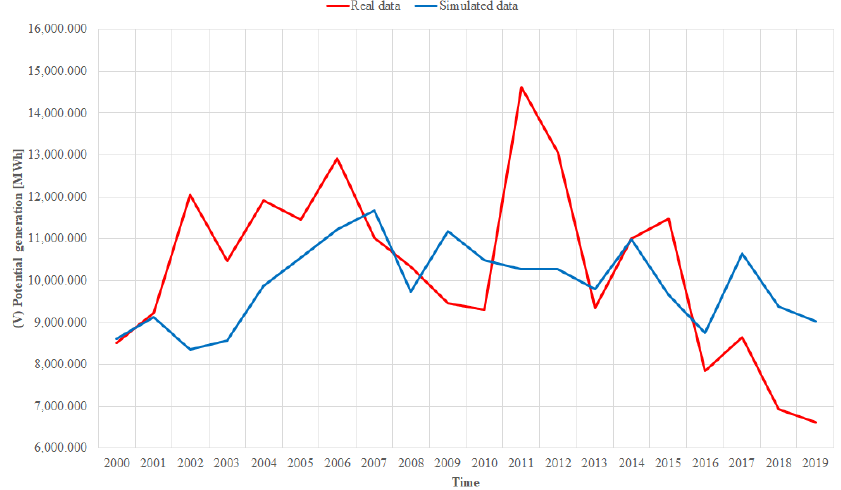
Figure 10. (V) Potential generation ( pg v ). The red signal represents the real behavior of the Colombian potential generation of the variable resources, obtained with data from [44]. The blue signal was computed with our SD/DS model. MAPE =